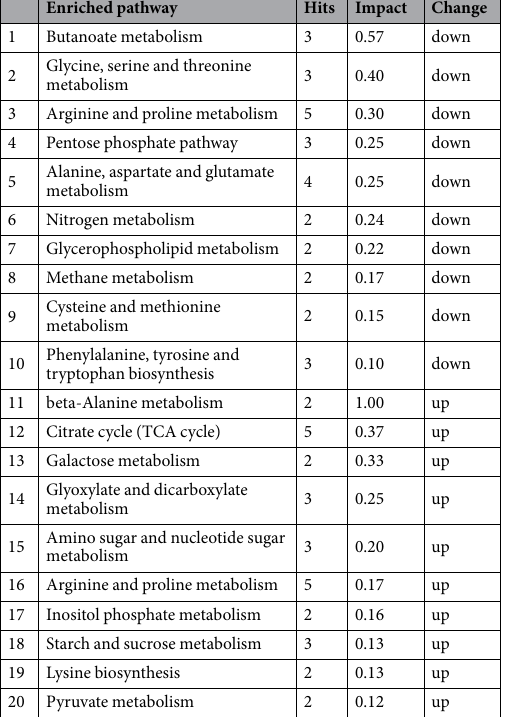
Table 1. Metabolic Pathways enrichment from the Significantly Different Metabolites between TG and CG.